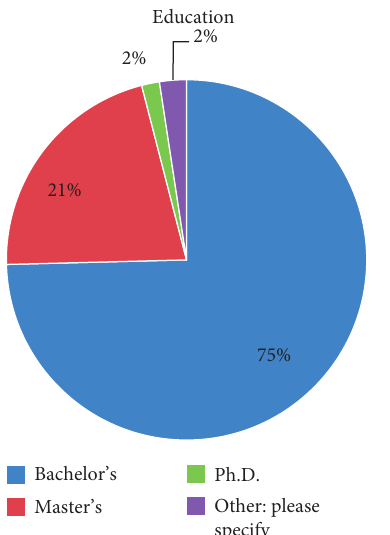
Figure 1: Education of the respondents.